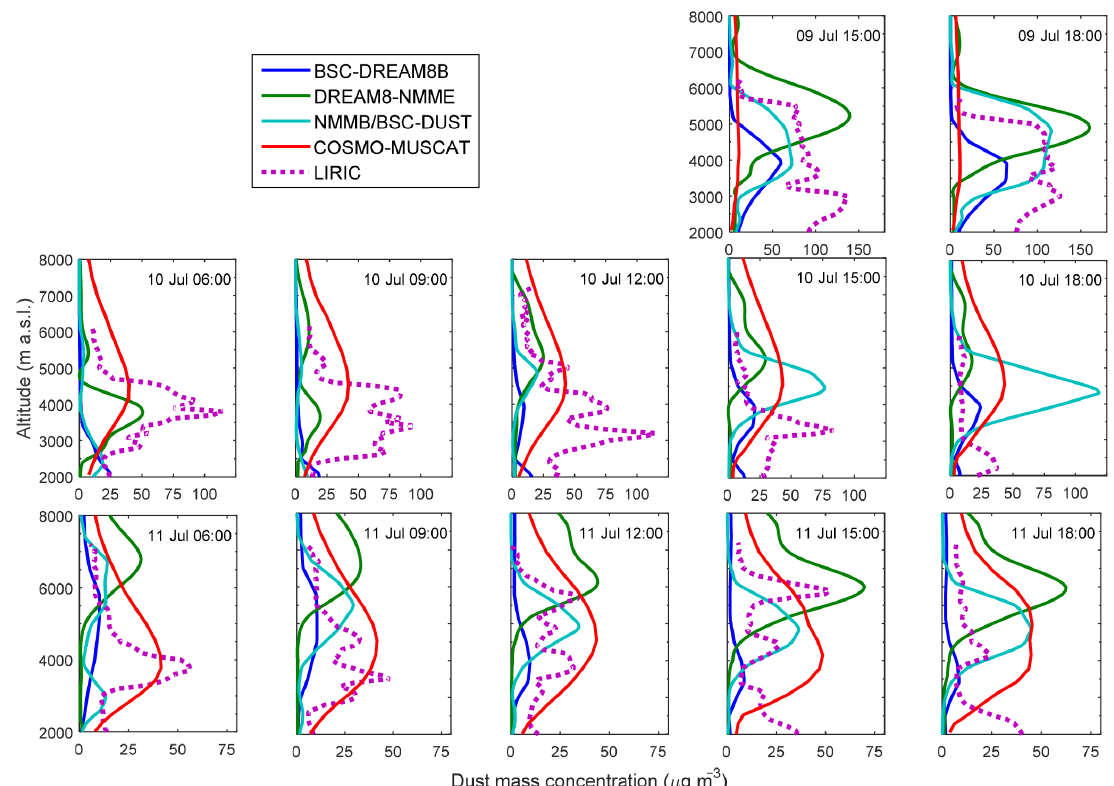
Figure 11. Dust mass concentration profiles obtained with LIRIC (dotted line) and BSC-DREAM8b-v2, DREAM8-NMME, DREAMABOL, and NMMB/BSC-Dust for Granada station every 3h on 9, 10, and 11 July